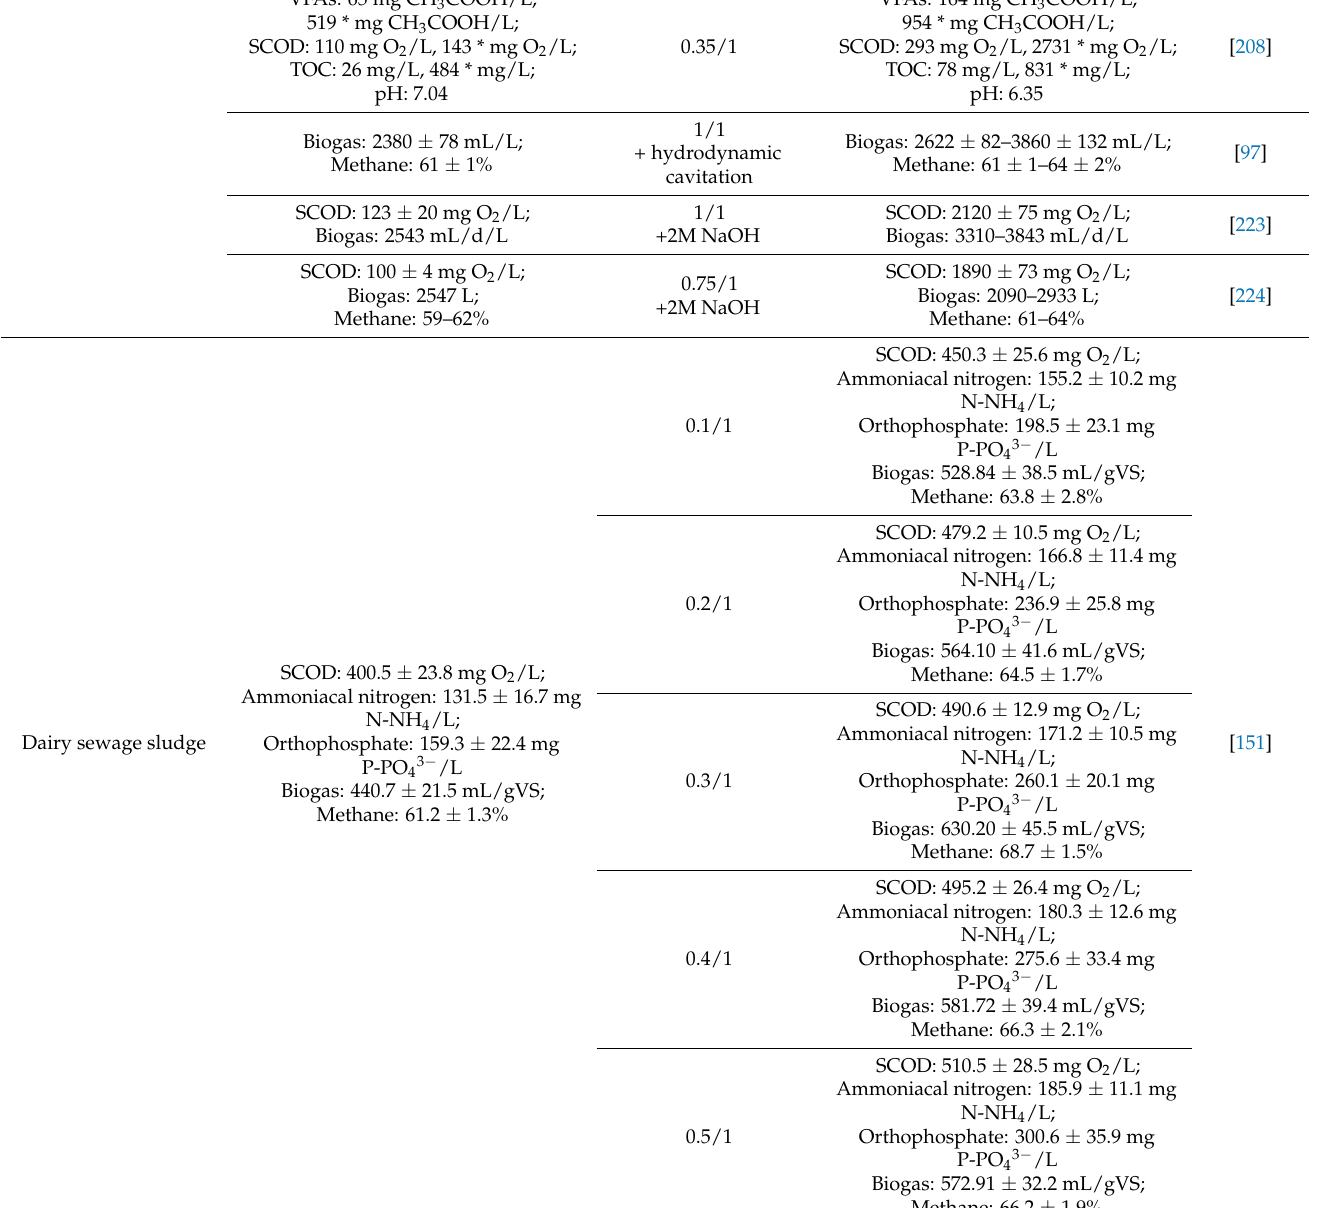
Table 7. Cont. Sewage Sludge before Pretreatment Sewage Sludge Processes